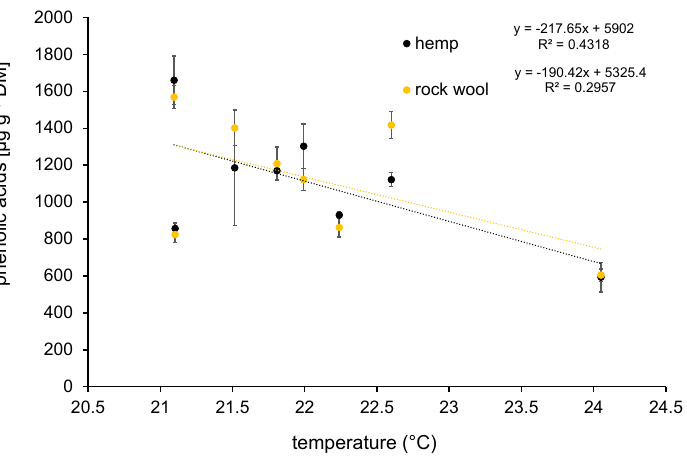
Figure 4. Correlation between phenolic compounds in tomatoes and temperature under consideration of different growing media.